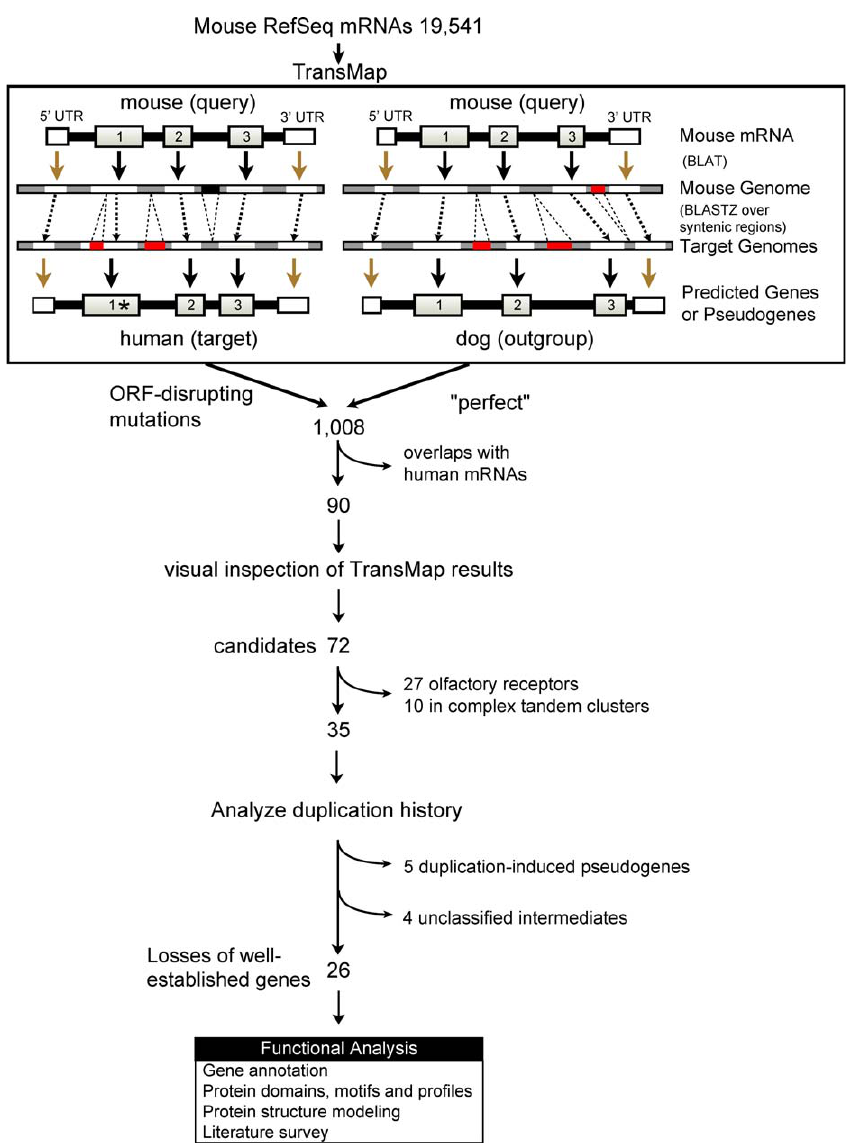
Figure 1. Algorithm for Identifying Losses of Well-Established Genes in the Human Lineage Since the Common Ancestor of Euarchontoglires TransMap predicts (pseudo)genes in the human and dog genomes by syntenically mapping mouse mRNA gene structures to the target genomes through genome alignments and then transferring over the corresponding genomic coordinates. The predicted coding regions are conceptually translated and scanned for ORF-disrupting mutations. In this example, a stop codon (labeled with an ‘‘ * ’’ ) is detected in the first coding exon mapped to the human genome, which has also experienced an insertion. Genomic insertions or deletions are shown as red rectangles. Of 19,541 mouse RefSeq genes, 1,008 are identified as initial candidate gene losses in the human lineage based on the differential mutation status in the TransMap results. The list is narrowed down to 72 after eliminating those overlapping with human transcription evidence and filtered out by a manual inspection. Twenty-six are identified as losses of well-established genes in the human lineage after analyzing their duplication histories.